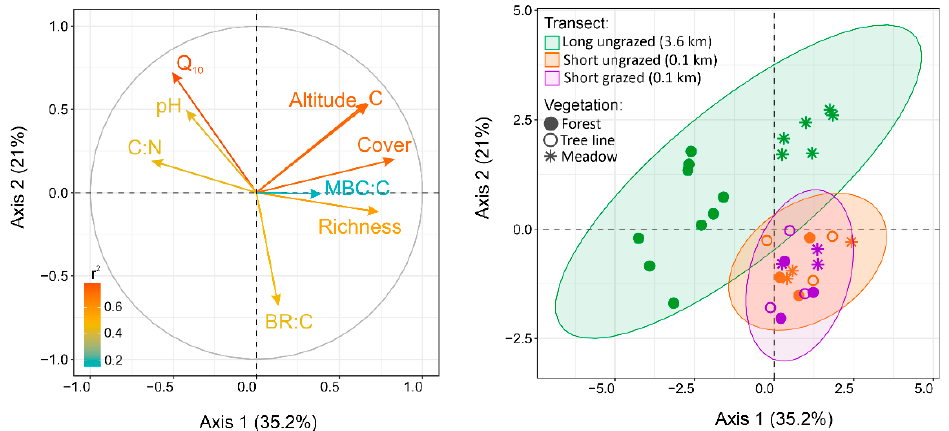
Figure 3. PCA results for studied plant and soil properties of mountain forest and meadow sites along long and short transects with different land use ( n = 33). Variable correlation plot (on the left) and plot of individual sites by groups (on the right). See variable abbreviations in Table 1.